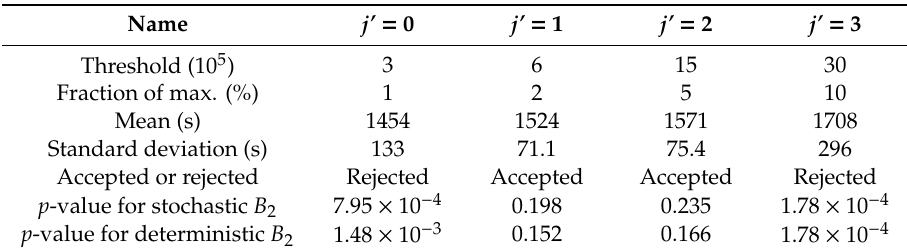
Table 6. The statistics about the latent periods for each